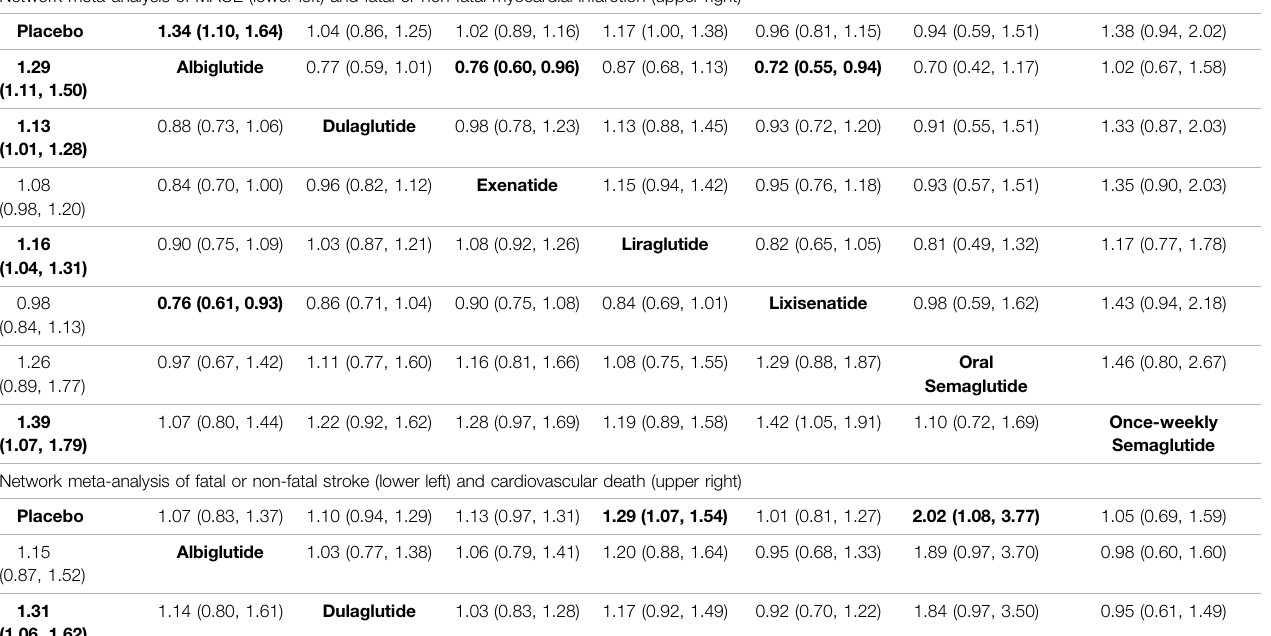
TABLE 2 | Network meta-analysis of nine primary outcomes. Network meta-analysis of MACE (lower left) and fatal or non-fatal myocardial infarction (upper right) Placebo